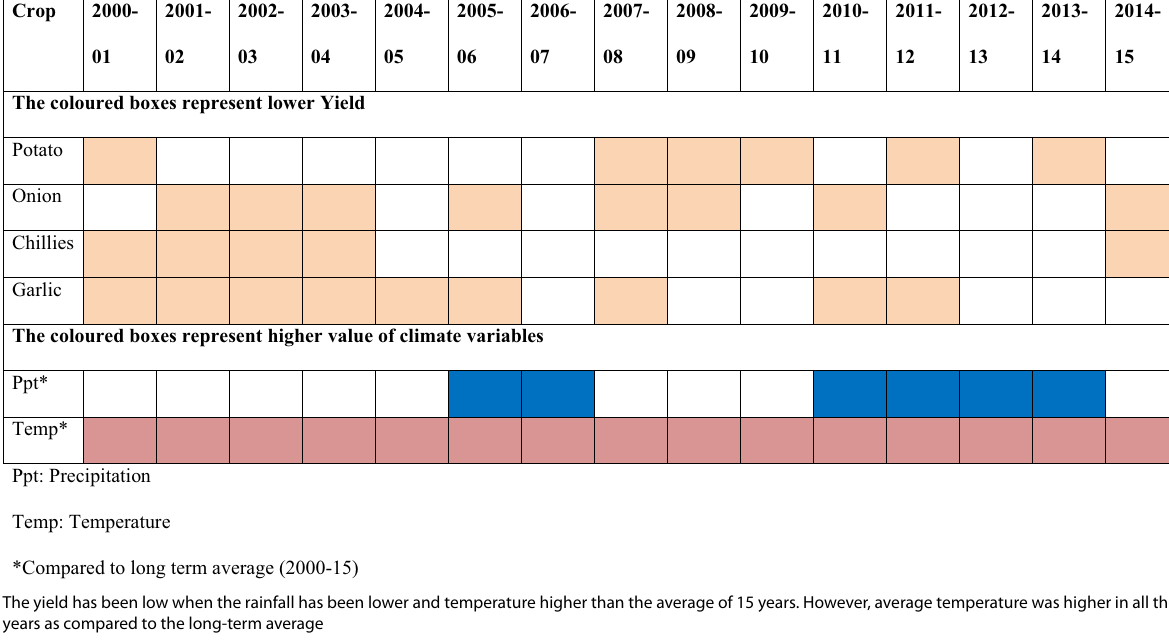
Table 7 Year-wise crop yield and average annual precipitation and temperature